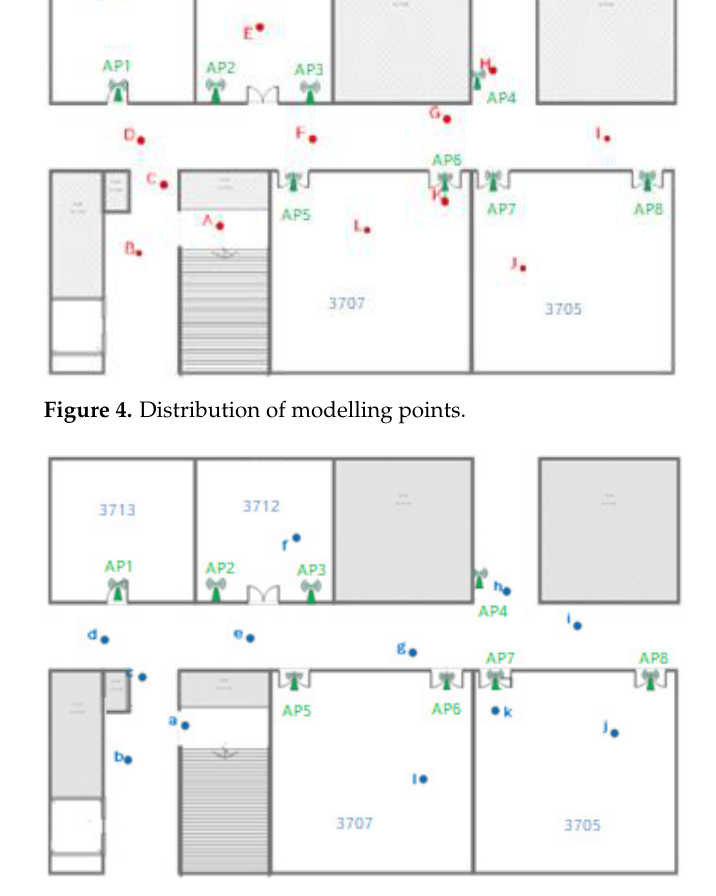
Figure 5. Distribution of test points.